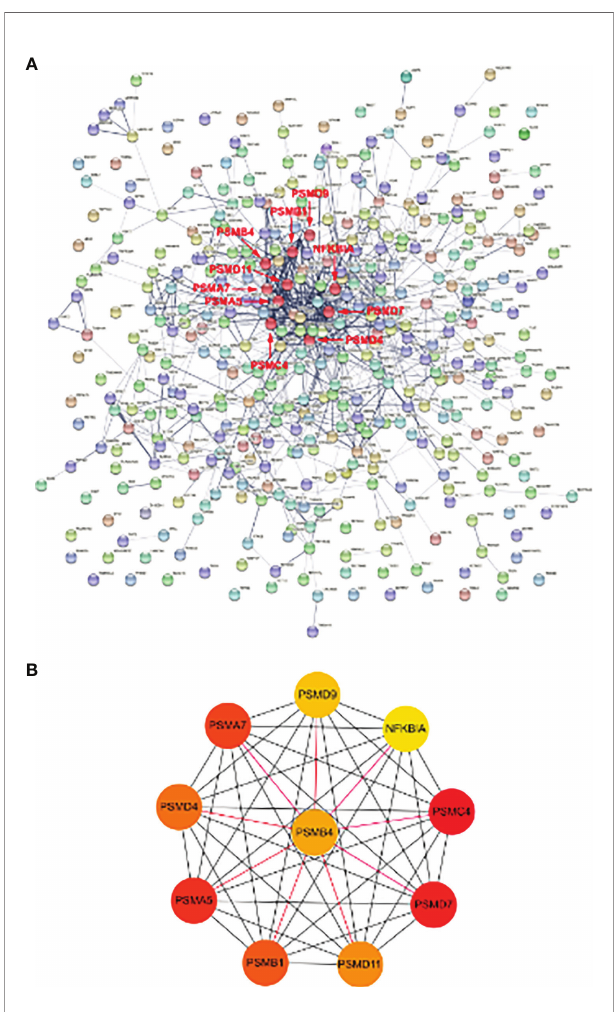
FIGURE 5 | PPI network of DE-mRNAs and hub genes identi fi cation. (A) The interaction network between proteins coded by DE-mRNAs was composed of 417 nodes and 922 edges. Each node represents a protein, whereas each edge represents one protein – protein association. The smaller the value of Q, the larger the shape size. (B) Cluster plots represent the top 10 hub genes identi fi ed by cytoHubba. Associations of hub genes are marked with red markers in the PPI network.